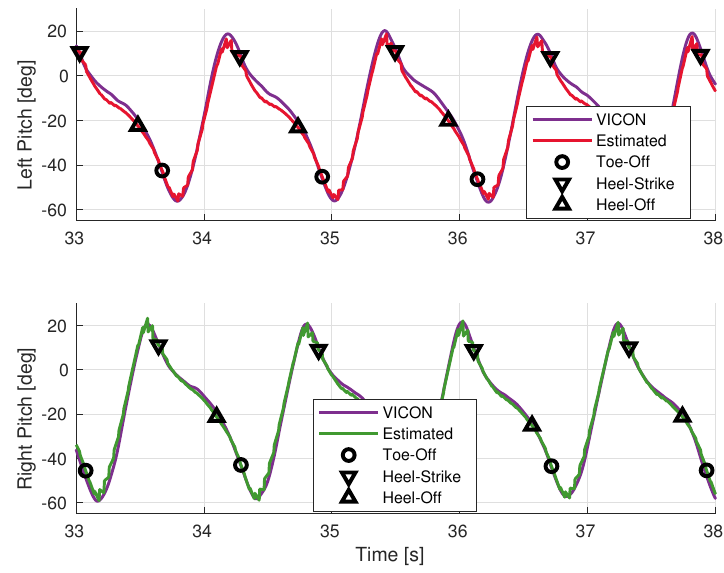
Figure 12. Comparison of shank pitch angles during